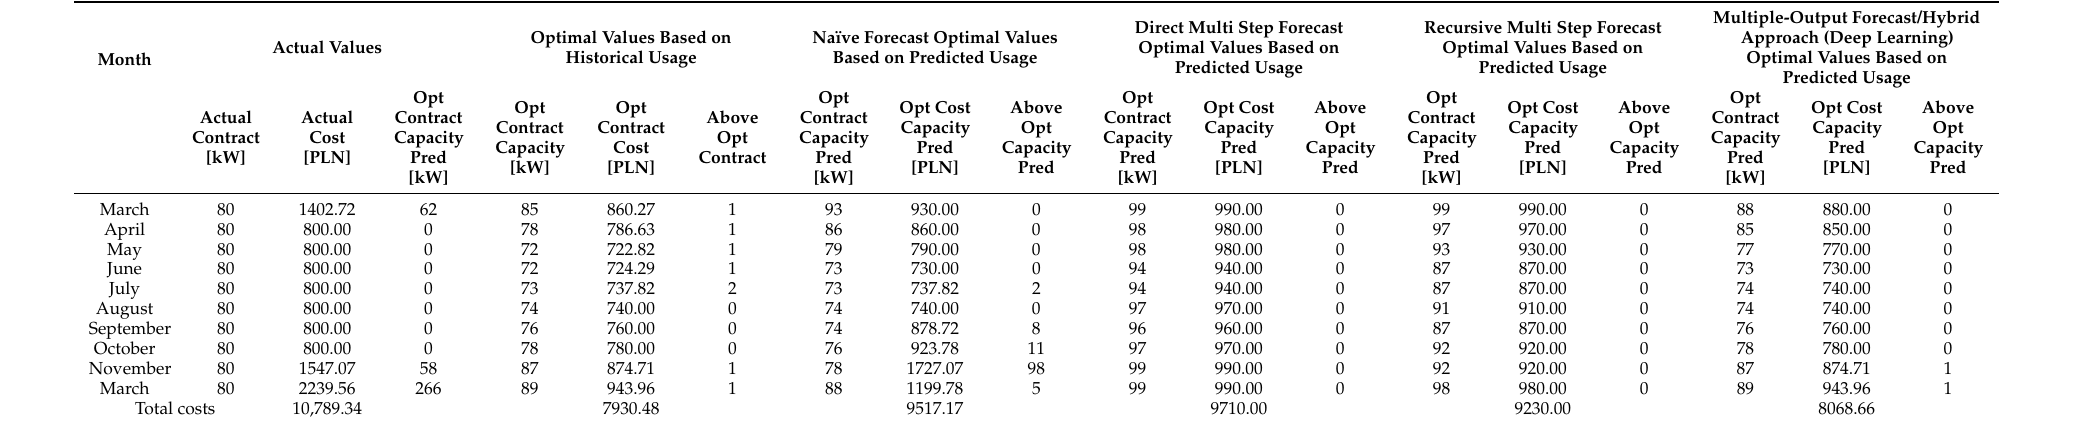
Table 2. The results with Q100 approach for C22b tariff